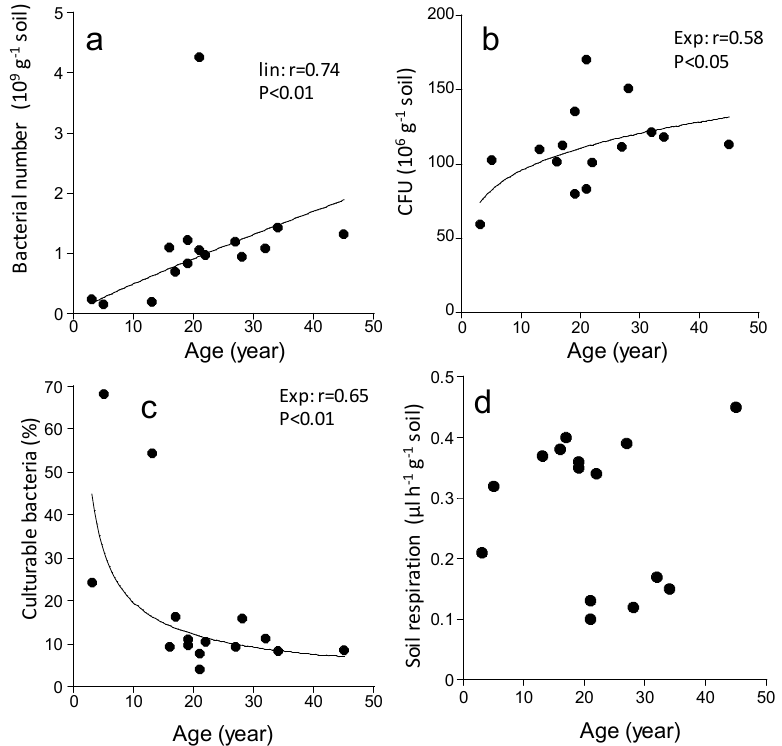
Figure 1. Relationship between site age and the total number of bacteria as determined by direct counts ( a ), number of culturable bacteria ( b ), percentage of culturable relative to the total number of bacteria ( c ), and soil respiration ( d ).